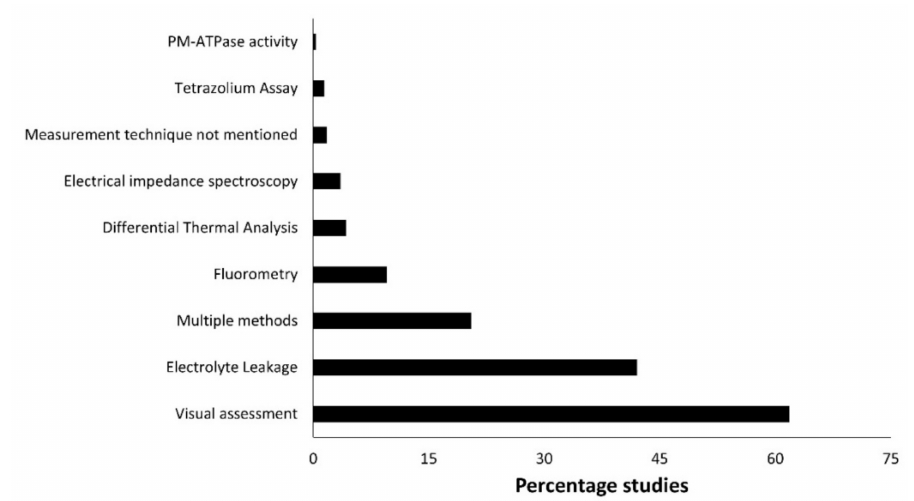
Figure 10. The frost tolerance measuring techniques used, by percentage of